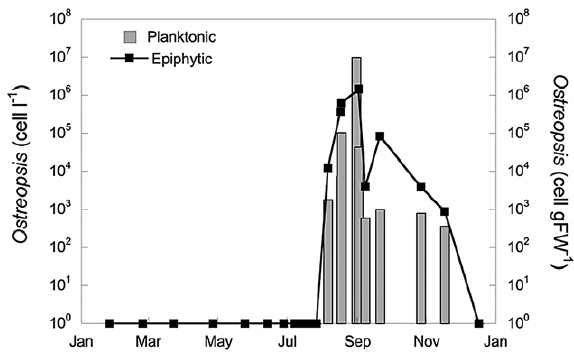
Fig. 2. – Ostreopsis sp. abundance in the plankton and in the epi- phytic community of the macrophytes in 2010.